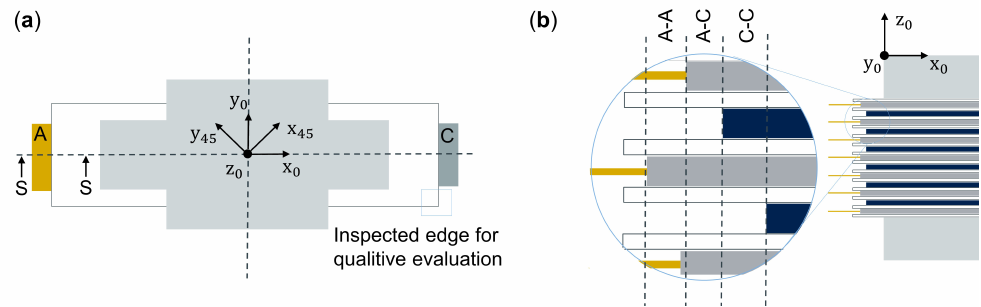
Figure 3. ( a ): Drawing of the ESC in top view. ( b ): Shown is the S-S Section illustrating the AC overhang in a detailed